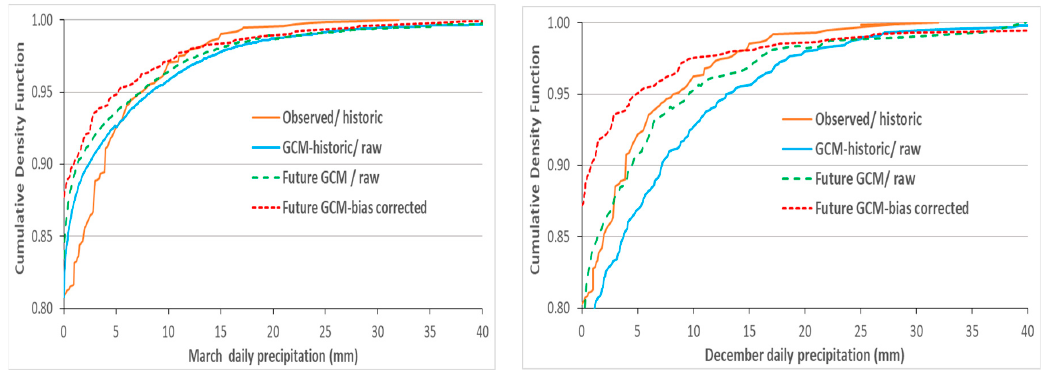
Figure 7. Empirical CDF for daily precipitation for reference raw GCM (1977–2005), future raw GCM for the RCP4.5 scenario (2006–2029) and QM- bias-corrected data at Nouroozloo station for March and December.